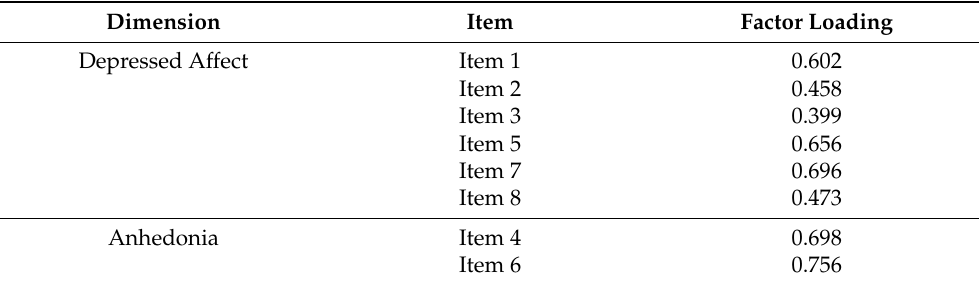
Table 3. Depressive Traits Non-Parcel CFA Model of the CFPS-2018 Participants ( n = 2173).